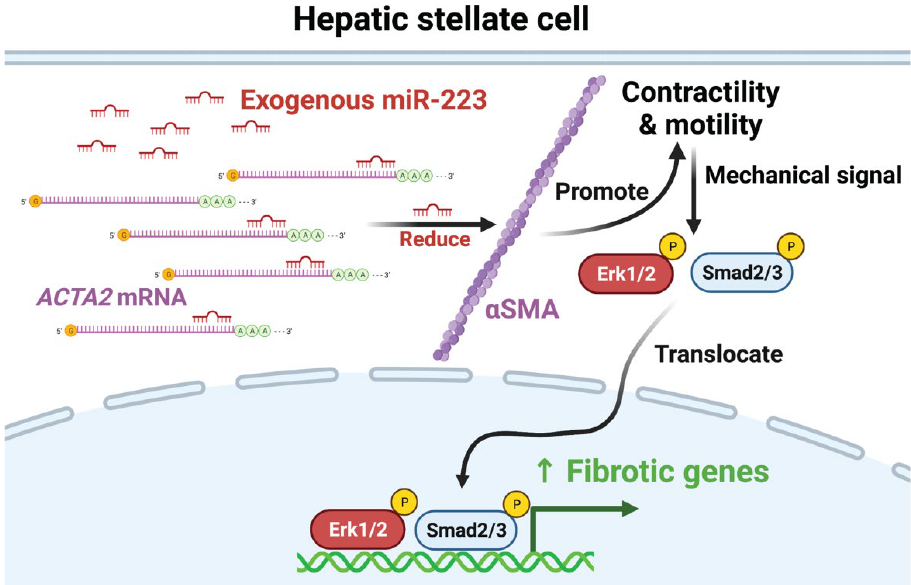
Figure 7. miR-223 suppresses HSC activation via modulating the actin cytoskeleton. Exogenous miR-223 can directly bind the 3′ UTR of ACTA2 transcripts, leading to reduced protein levels of α -SMA. Impaired cytoskeletal activity then attenuates fibrogenic signaling pathways, including phosphorylation of Erk1/2 and Smad2, and reduces expression of fibrotic genes.